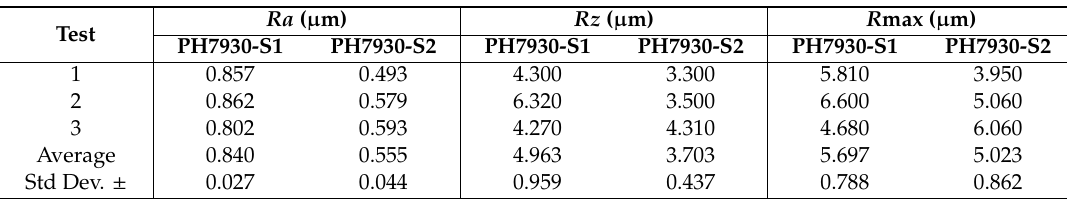
Table 7. Surface roughness for the workpiece surface generated by PH7930 PVD AlTiN coated insert with a cutting length of 3.94 m